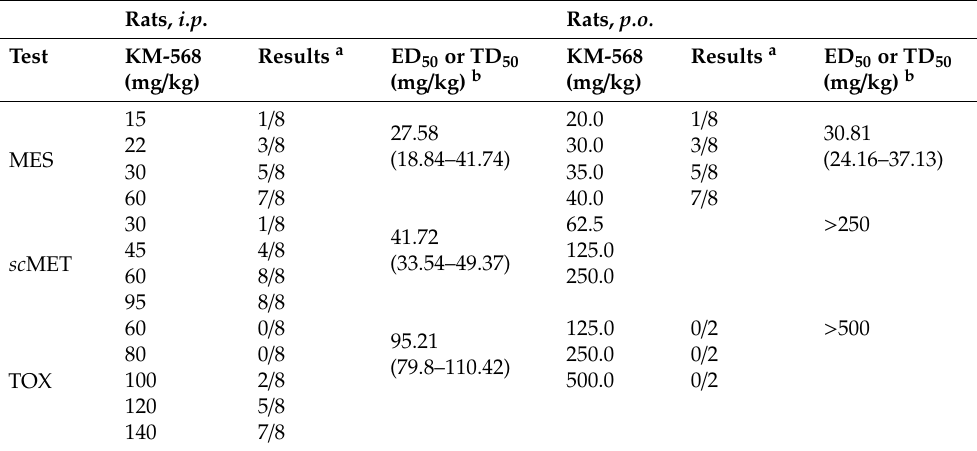
Table 2. Biological response in anticonvulsant and neurotoxicity evaluation in rats after intraperitoneal ( i.p .) and oral ( p.o .) administration of KM-568. Rats, i.p . Rats,